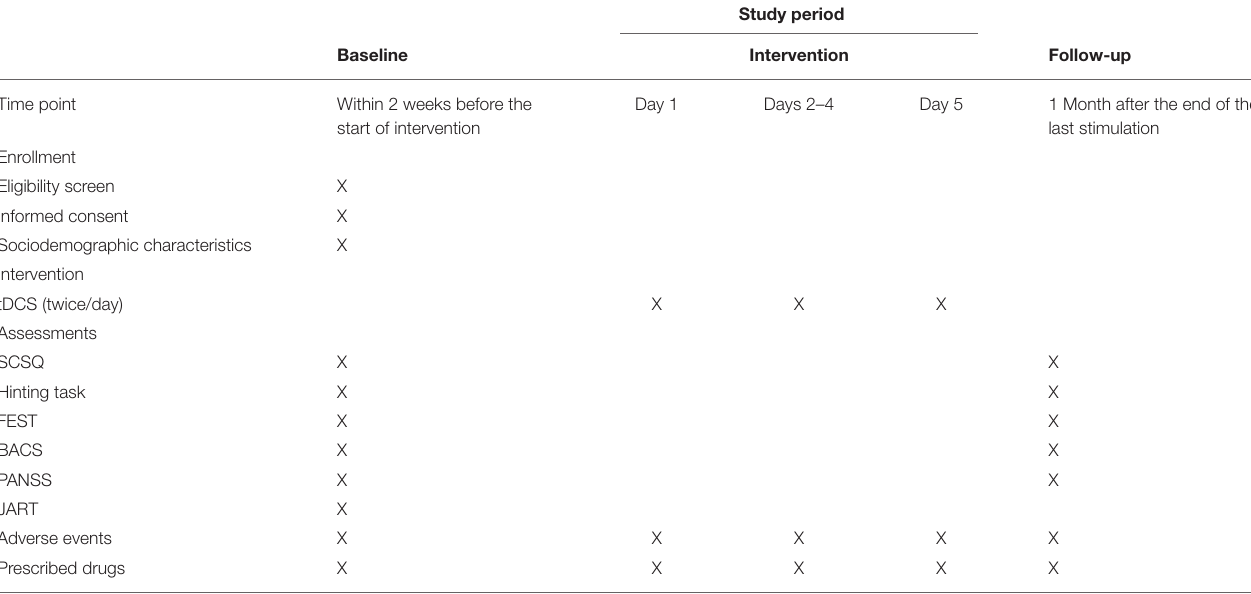
TABLE 3 | Study schedule [Yamada et al.